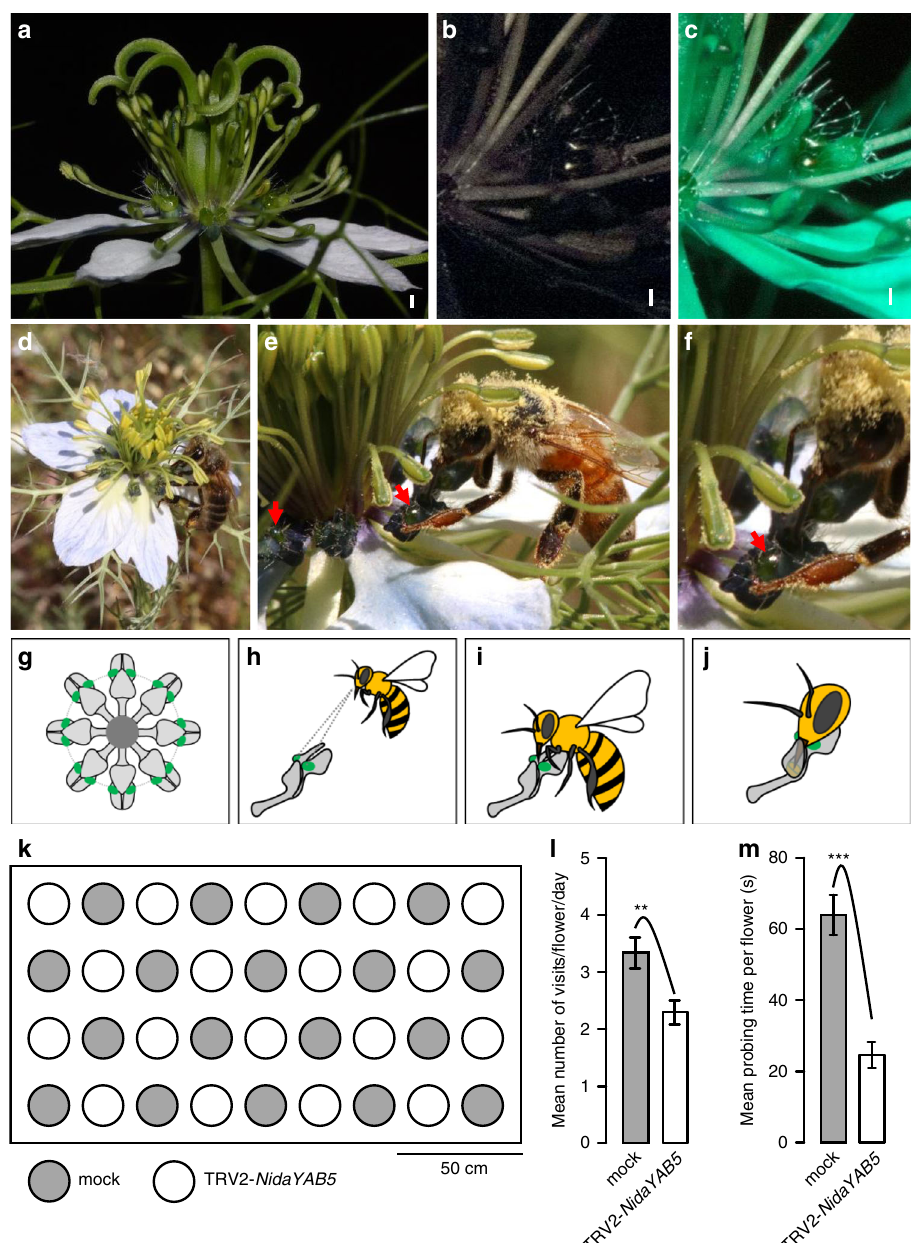
Fig. 6 The optical properties and ecological function of pseudonectaries. A wild-type fl ower under visible light ( a ), ultraviolet light ( b ), and bee vision ( c ). Scale bars: 1 mm. d – f Photographs show honey bees ( Apis mellifera ) forging for nectar. Red arrows indicate the pseudonectaries. The pseudonectary in e is magni fi ed and shown in f . g Petals and pseudonectaries in a wild-type fl ower, with all other fl oral organs being omitted. h – j Visitation of a petal by a honeybee. k Schematic layout of the mock and TRV2- NidaYAB5 -treated fl owers with strong phenotypic changes for pollination studies. Comparisons of the visiting frequency ( l ) and probing time ( m ) of honey bees, the most effective pollinators, on the mock and TRV2- NidaYAB5 -treated fl owers. The asterisks indicate the signi fi cant differences by two-side Wilcoxon rank sum test ( P < 0.01 and P < 0.001, respectively) between samples. p = 0.006654 for l and p = 1.396e − 08 for m . n = 18, both for mock and TRV2- NidaYAB5 -treated fl owers for four independent experiment days. Error bars indicate the standard error (SE) of the mean visiting frequency or probing time of 4 days. Data are presented as mean values ± SE. Source data for l and m are provided as a Source Data fi